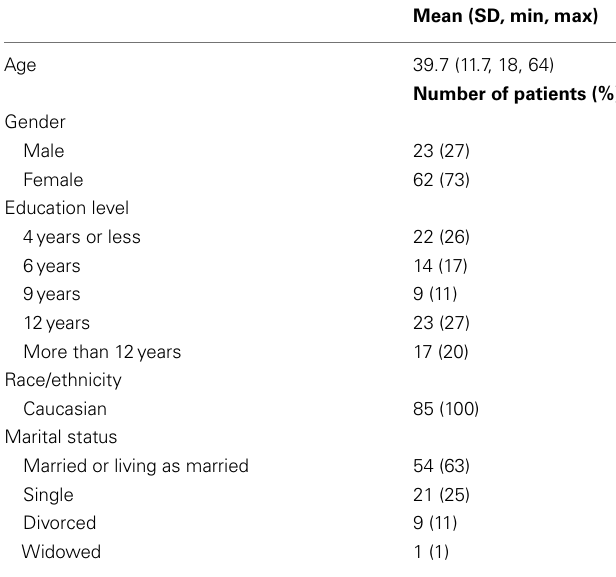
Table 1 | Demographic characteristics of the MS patient sample.